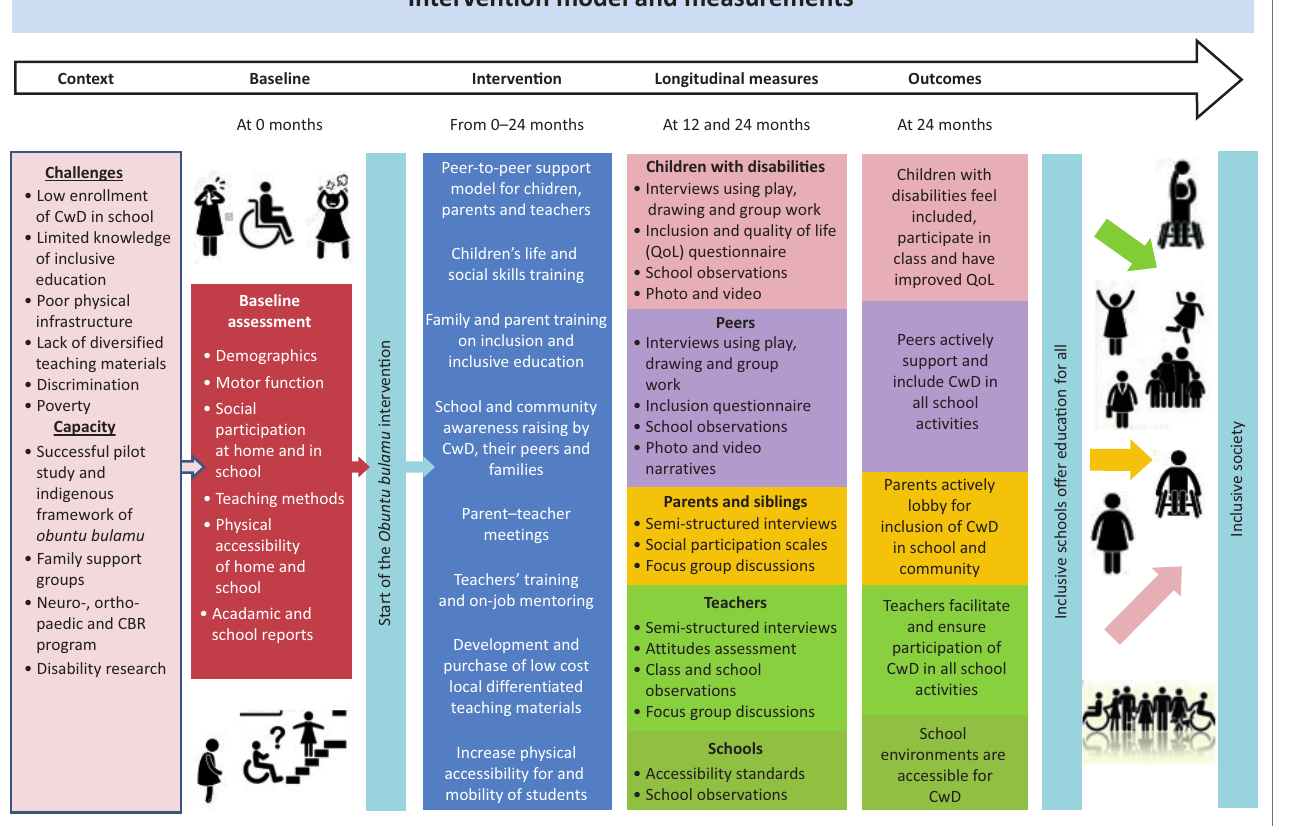
FIGURE 1: Theory of change for the obuntu bulamu